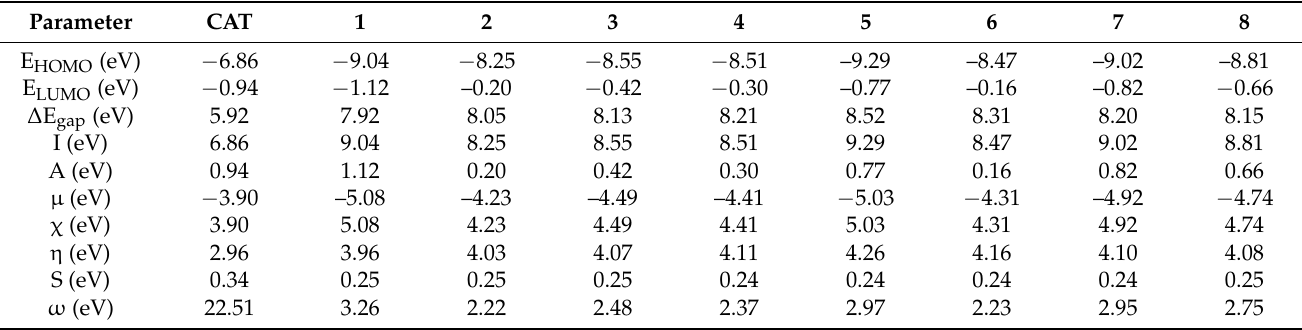
Table 5. Frontier molecular orbital energies of the synthesized